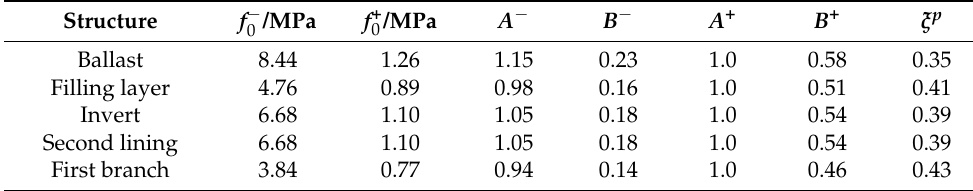
Table 8. Mechanical damage parameters of